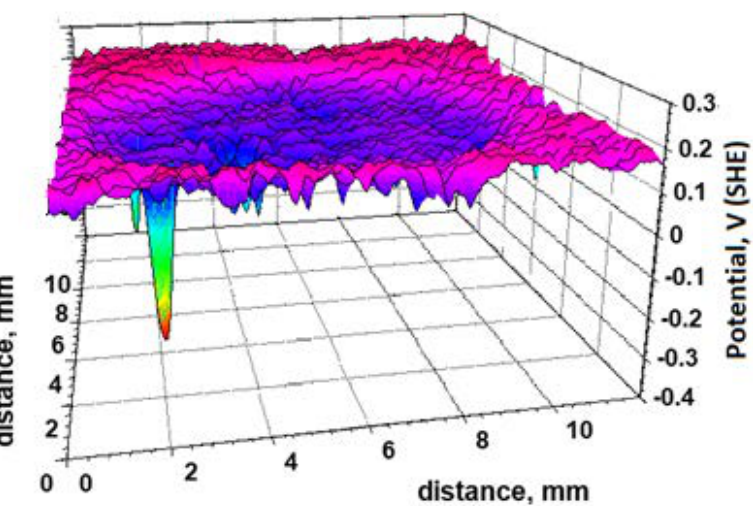
Figure 10. Potential map of the permeation side of the HSS 1500 steel membrane (thickness 0.5 mm). The steel was pre-charged using a current density of − 10 mA/cm 2 in 0.1 M NaOH for 3 h. SKP measurements were carried out in air at 60%RH 1.5 h after treatment.